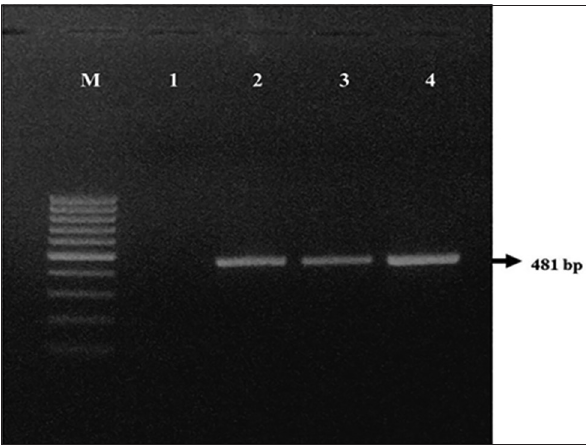
Figure-2: 481 bp amplicon characteristic of 16S rRNA gene of Clostridium perfringens. Lane M: 100 bp DNA ladder. Lane 1: Negative control. Lane 2: Positive control. Lanes 3-4: Isolates positive for C.